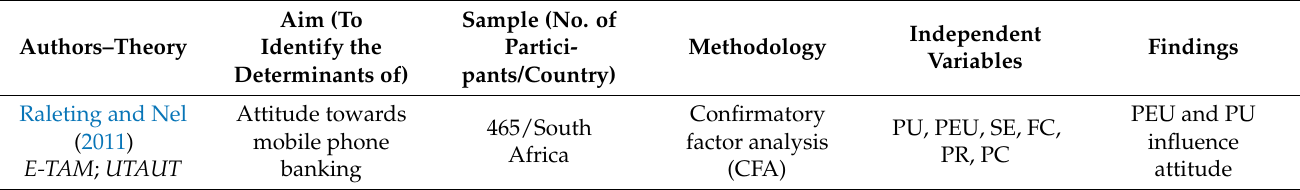
Table 3. Taxonomy of prior